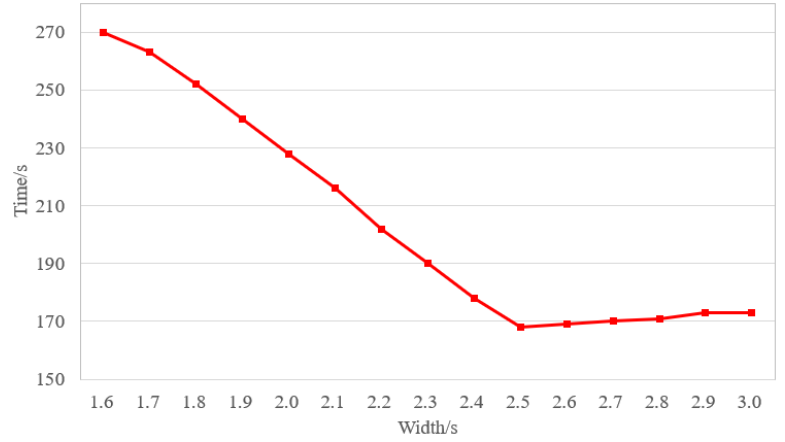
Figure 21. Relationship between escalator width and evacuation time.